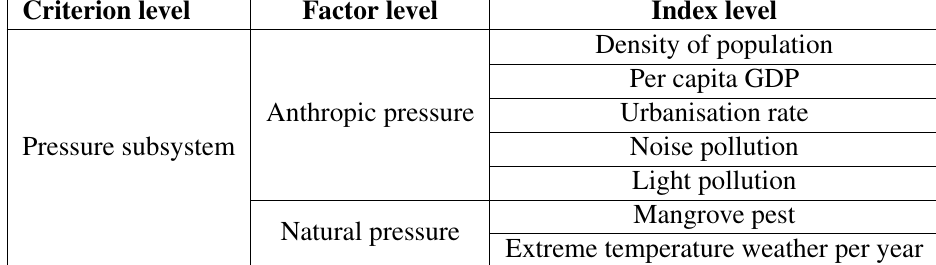
Table 1 Evaluation index selection of the pressure